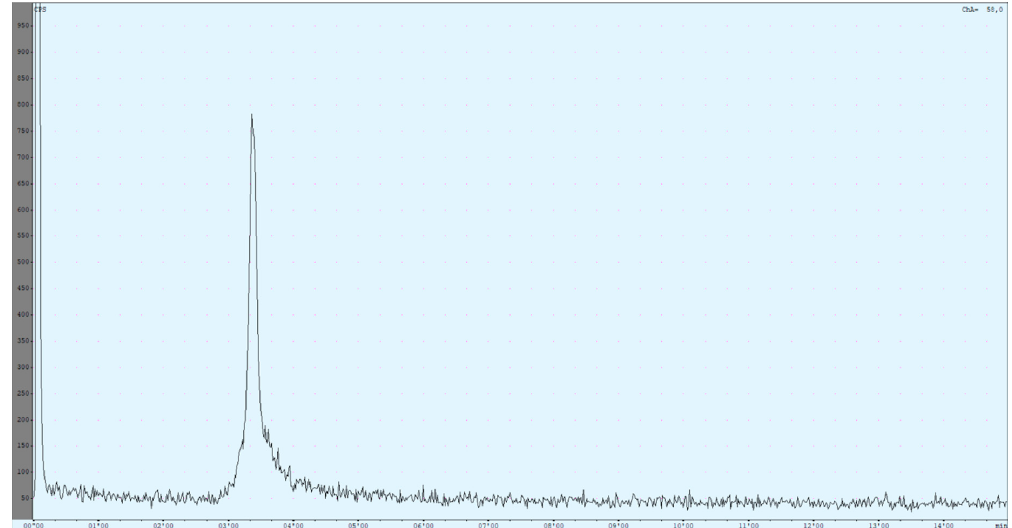
Figure 5. The currently used high-performance liquid chromatography (HPLC) method utilises an isocratic mixture of 90% 59-mM TBAP/10% MeOH (1.2 mL/min). The chromatogram shows the result of a [ 68 Ga]Ga-DOTA-ZOL synthesis (complexation yield determined with radio thin-layer chromatography (TLC) was 98%). The first peak refers to all injected activity measured before the column. The ratio between both peaks is nearly 50:50.